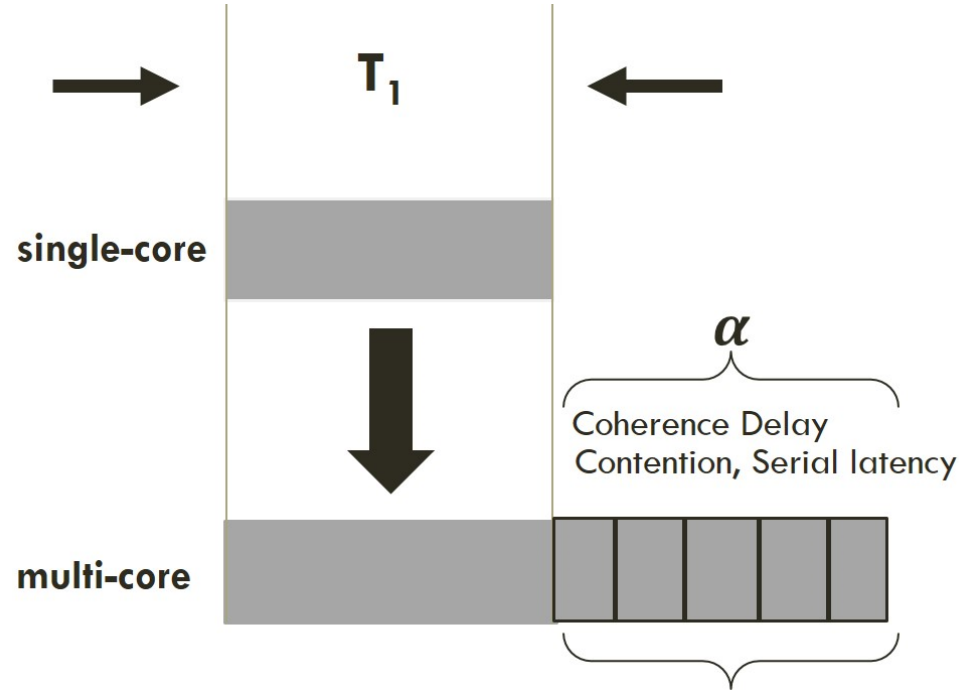
Figure 2. Effect of multiuser scale-up increases response time in accordance to multi-core processors.